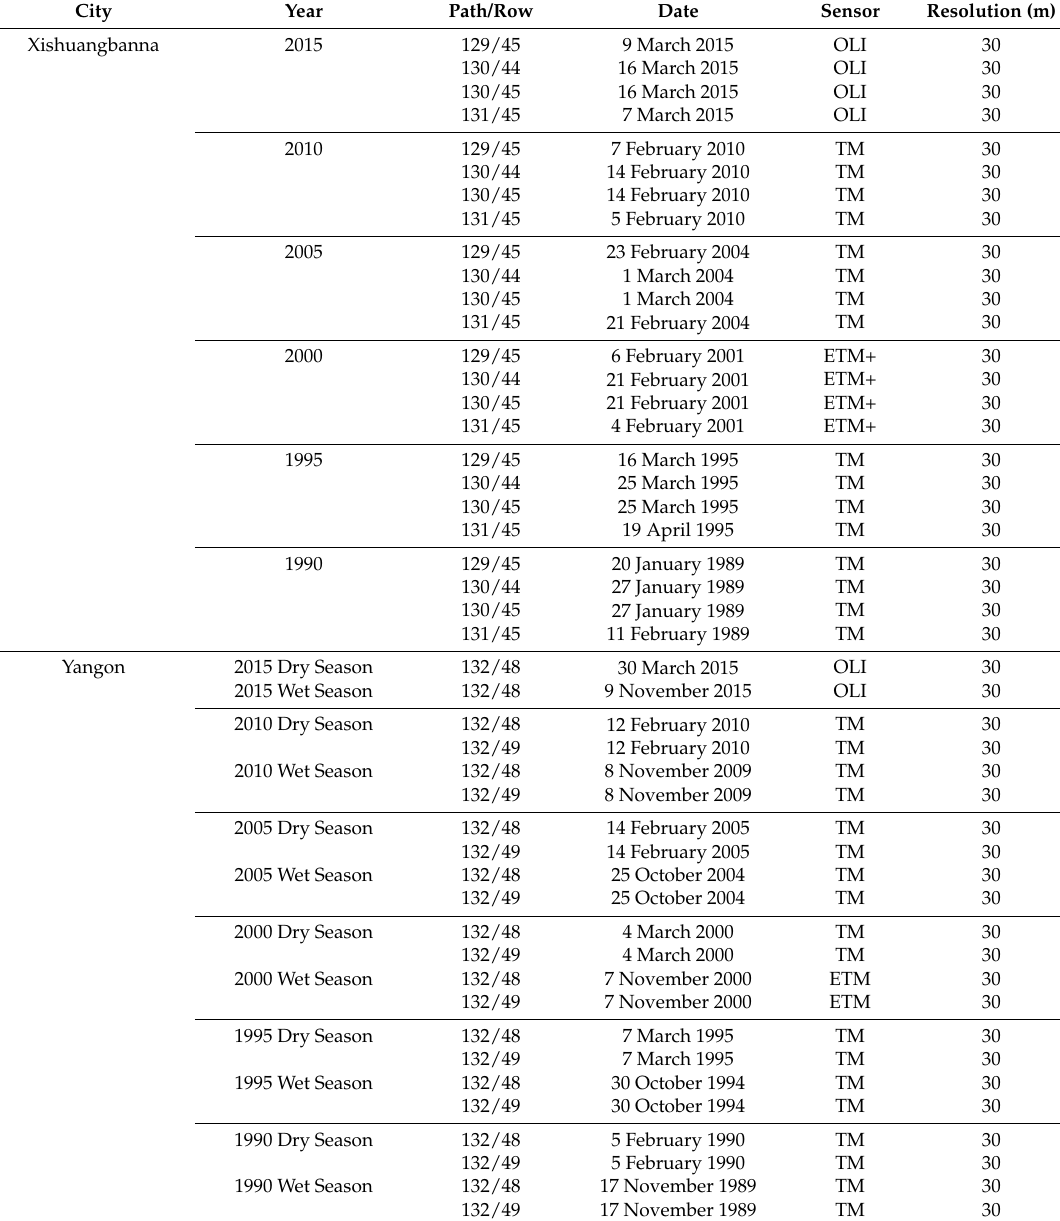
Table A1. List of Landsat Images used in the